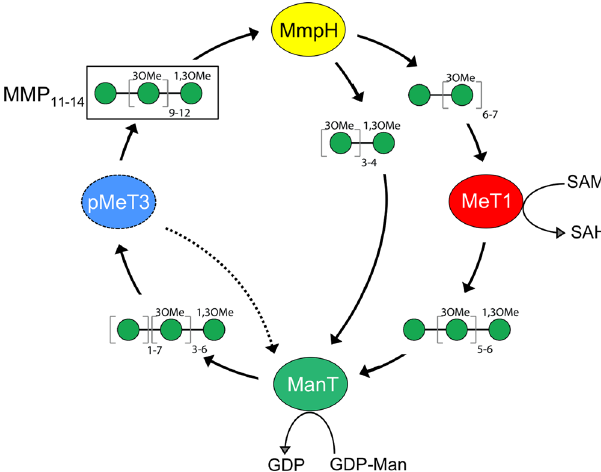
Fig. 7 Proposed self-recycling mechanism for partially conservative biogenesis of mycobacterial MMP. This mechanism relies on the hydrolytic activity of MmpH toward MMP, followed by the synthesis of new daughter MMP molecules occurring by the coordinated action of ManT, MeT1 and pMeT3. A dashed arrow indicates putative alternating ManT and pMeT3 activities proposed to be required for full assembly of mature MMP 21,22 . MeT1, MMP 1- O -methyltransferase; MmpH, MMP hydrolase ( α - endomannosidase); pMeT3, putative MMP 3- O -methyltransferase; ManT, MMP α -(1 → 4)-mannosyltransferase; SAM, S -adenosyl methionine; SAH, S - adenosyl homocysteine; GDP-Man, Guanosine 5 ′ -diphospho- α -D- mannose; GDP, Guanosine 5 ′